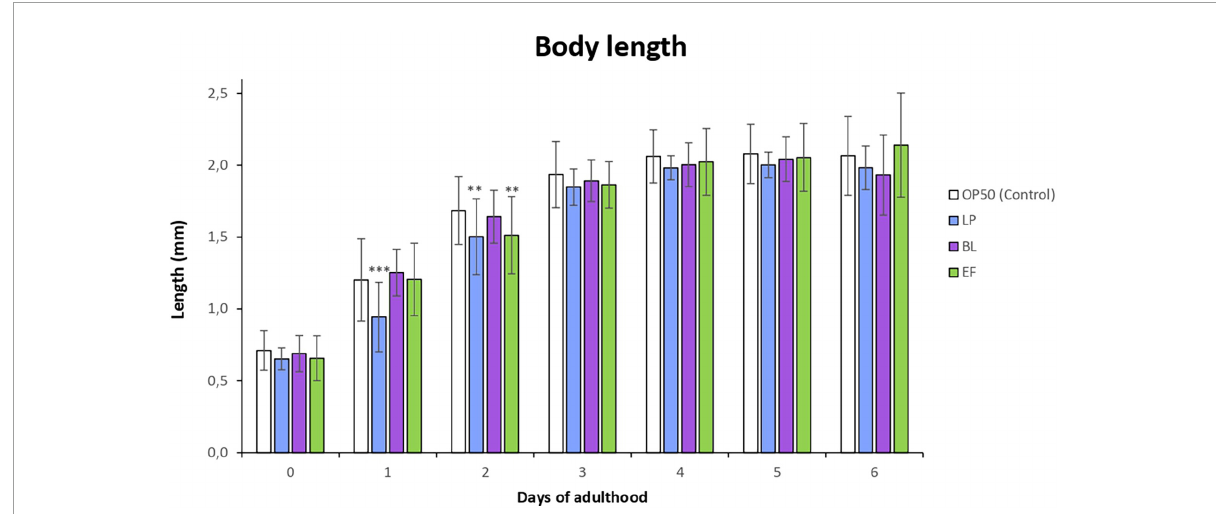
FIGURE1 Changes in body length in C. elegans fed Lactobacillus plantarum CLC17 (LP), Bifidobacterium longum NCIMB 8809 (BL), Enterococcus faecium CECT 410 (EF) and E. coli OP50 (control) from 1st to 6th day of worm adulthood. The error bars represent standard deviation ( n = 30). Differences in body length in worms fed LAB bacteria vs. E. coli OP50 were considered significant at *** p < 0.001, ** p <